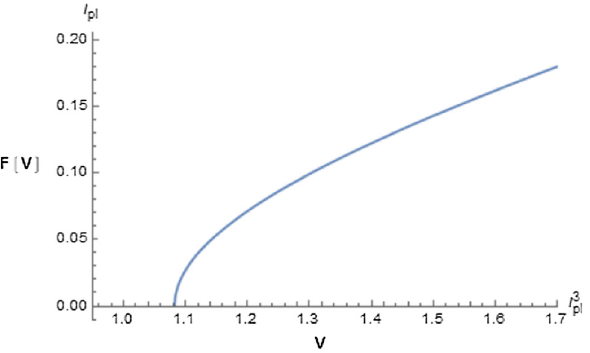
Fig. 7 The figure shows the function | ψ( V ) | 2 solution of (67) for dif- obtained through T ( V ) ferentenergyeigenvalues.Themoretheenergygrowsthemore | ψ( V ) | 2 is